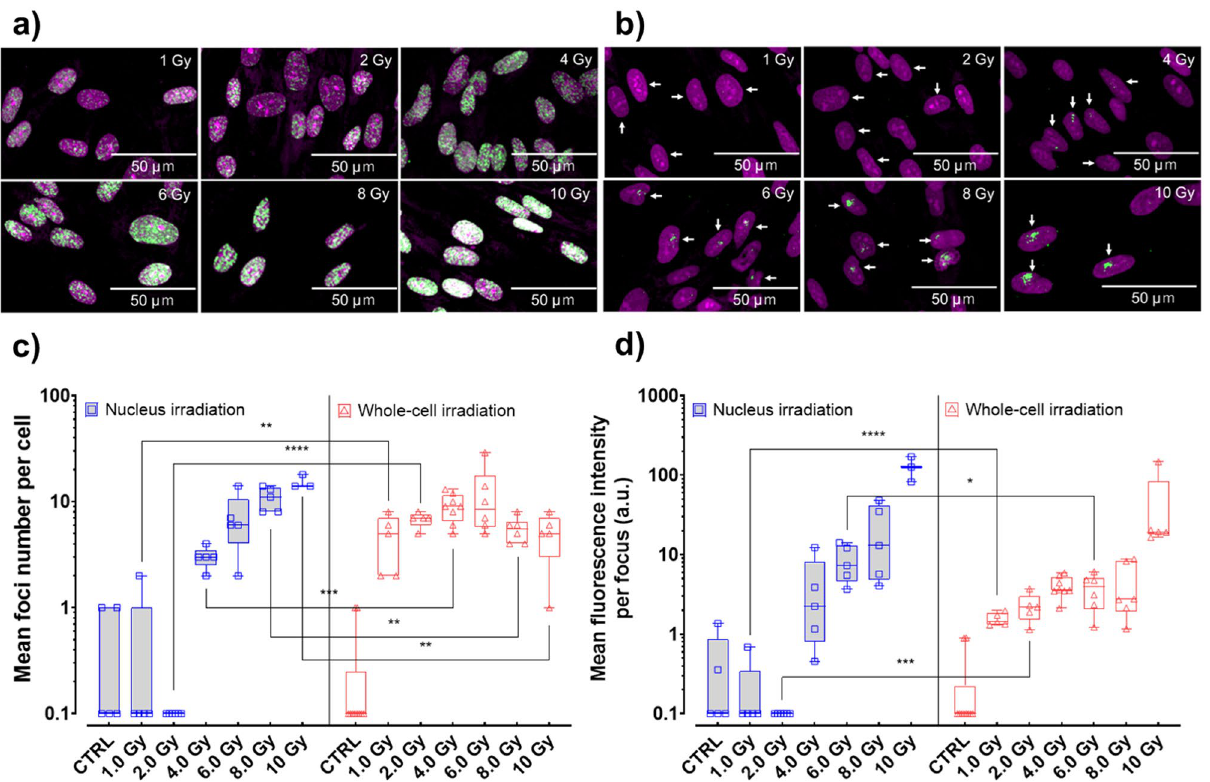
Figure 4. Accumulation of phosphorylated histone H2AX (γ-H2AX) foci in WI-38 cells after 30 min of nucleus or whole-cell irradiation. γ-H2AX foci formation following the irradiation of WI-38 whole cells ( a ) or WI-38 nuclei ( b ). White arrows in ( b ) identify irradiated cells. Propidium iodide staining and γ-H2AX foci in the captured images are presented as magenta and green signals, respectively. During imaging analysis, the mean foci number in irradiated WI-38 cells ( c ) and the mean fluorescence intensity at a focus in WI-38 cells ( d ) are measured using Image-Pro Plus 7.0. CTRL, nonirradiated control cells. To make a quantitative comparison, analysis was performed using images acquired under the same condition in the same batch of experiments. Results are shown by box-and-whisker plots with individual data points. The boxes indicate the 25–75th percentile, the line in the boxes indicates the median, and the whiskers indicate the range (minimum to maximum) of the data. p-values ( ns not significant, *p < 0.05, **p < 0.01, ***p < 0.001, ****p < 0.0001) in ( c ) and ( d ) calculated with Student’s t test. p-values for each comparison pair are also shown in Supplementary Tables S5 and S6